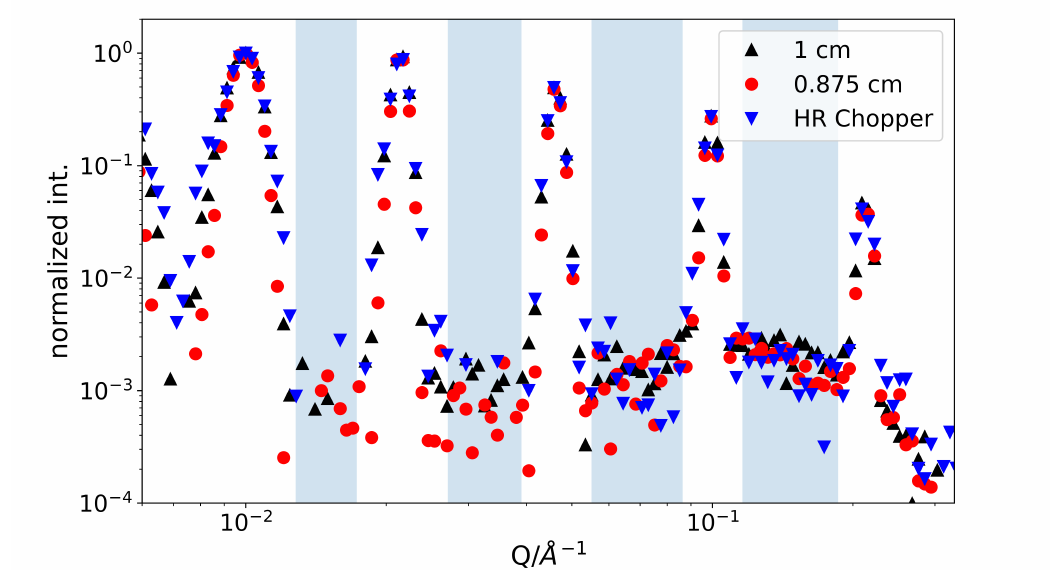
Figure 5. A set of simulated δ -peaks for different instrument configurations. While there is no major impact on the resolution for the additional choppers, the background is considerably lowered. Additionally, the absolute number of neutrons transmit- ted in the useful Q-band is higher by a factor of 2 for the chopper setup. Simulations where performed for 20 m collimation and sample apertures of 1 cm ( (cid:78) ) , 0.875 cm ( • ), and with 1 cm sample aperture using the high-resolution choppers ( (cid:72) ). For better visibility, the lower cutoff is at a normalized intensity of 1 × 10 − 4 . In order to ascertain the respective background intensities, the intensities have been summed over the areas that are shaded blue, which results in 0.074 for the 1 cm slit opening, 0.062 for the 0.875 cm slit opening, and 0.056 for the high resolution chopper